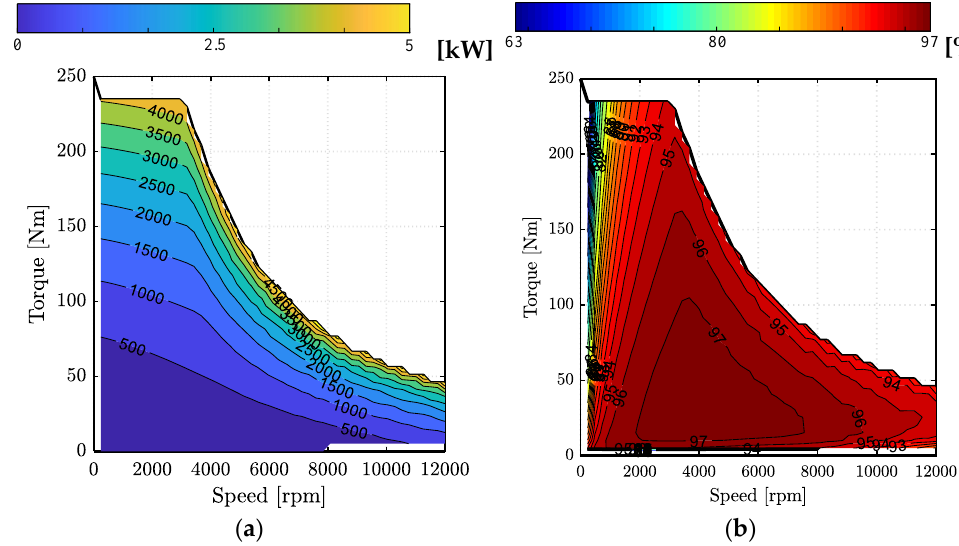
Figure 2. The loss and efficiency maps of a sample 50 kW IPMSM subject to operation at its maximum efficiency in each operating point. The studied IPMSM is designed for EV application. The data of this plot has been collected from [20,24]. ( a ) Total loss map of an IPMSM. ( b ) Efficiency map of an IPMSM.